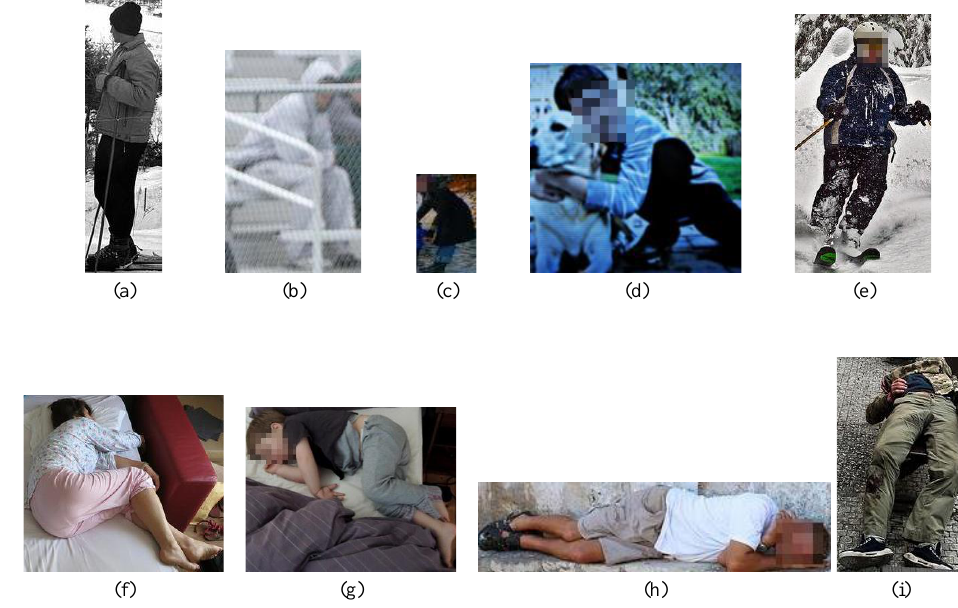
Figure 2. Some images in the LIP data set are not suitable to be used as the foreground, such as ( a ) black-and-white image; ( b ) blurred image; ( c ) low resolution image; ( d ) severe occlusion image, and ( e ) an image with no body parts exposed. ( f – i ) are good image samples we keep to generate composite images. We blur faces for privacy